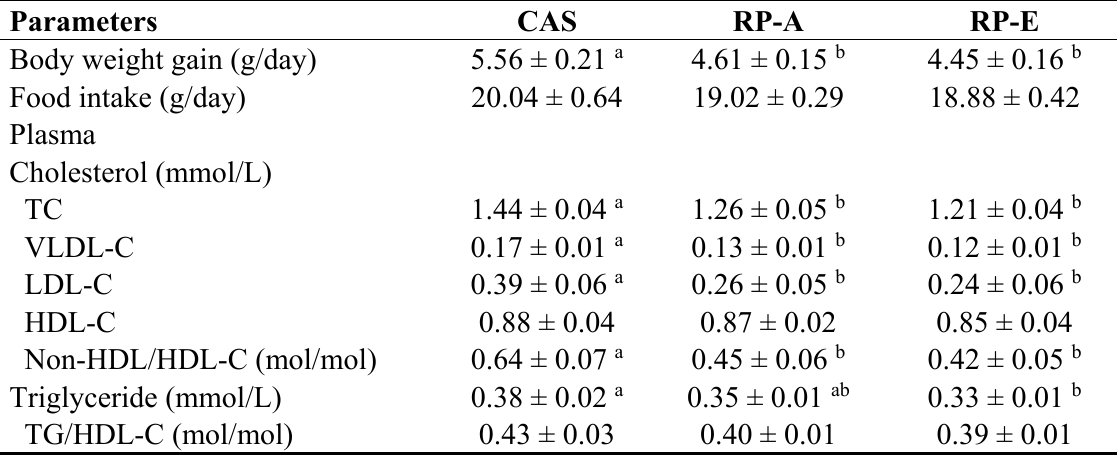
Table 4. Body weight gain, food intake and plasma lipids in